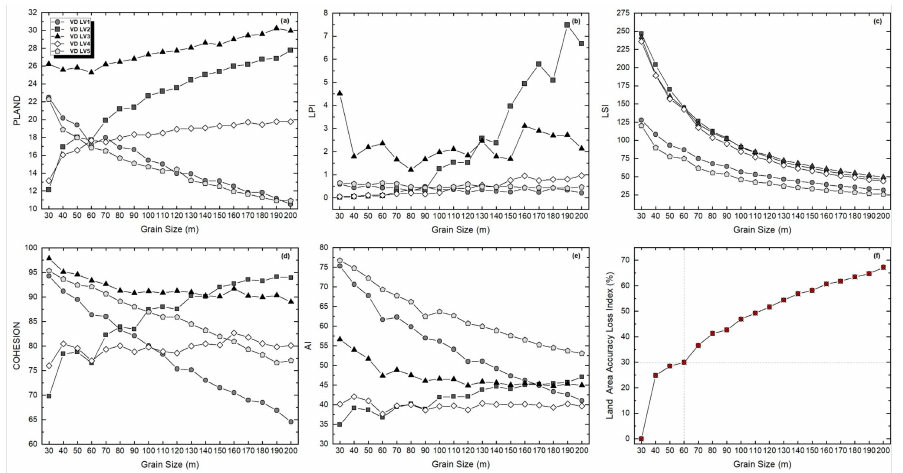
Figure A1. ( a – e ) Response curves of class − level metrics against variations in grain size; ( f ) land area loss index curve corresponding to grain size